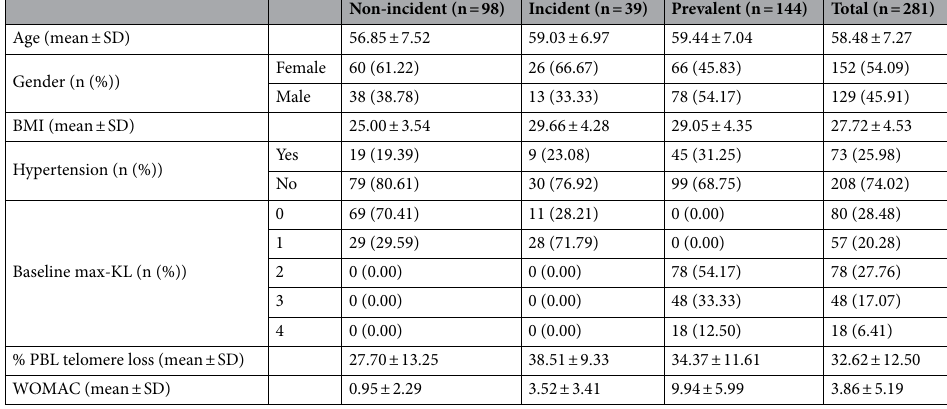
Table 1. Characteristics of the